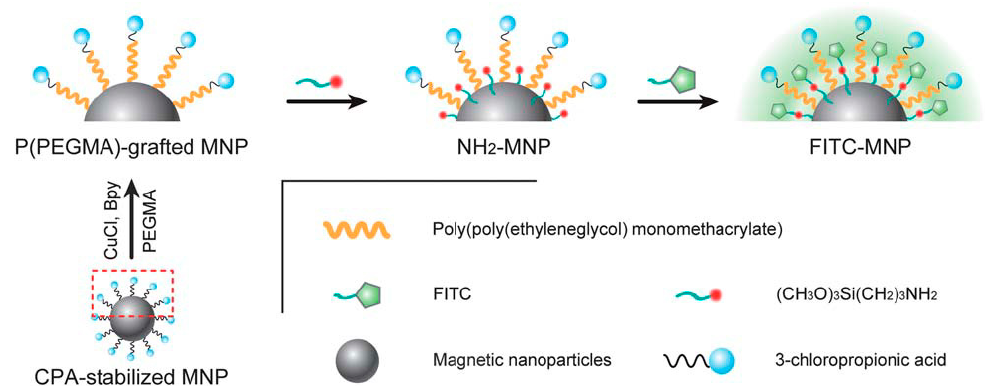
Figure 9. Preparation route of NH 2 -MNPs and FITC-MNPs from P(PEGMA)-MNPs by post- polymerization modification (MNPs—magnetic nanoparticles). Adapted from ref.